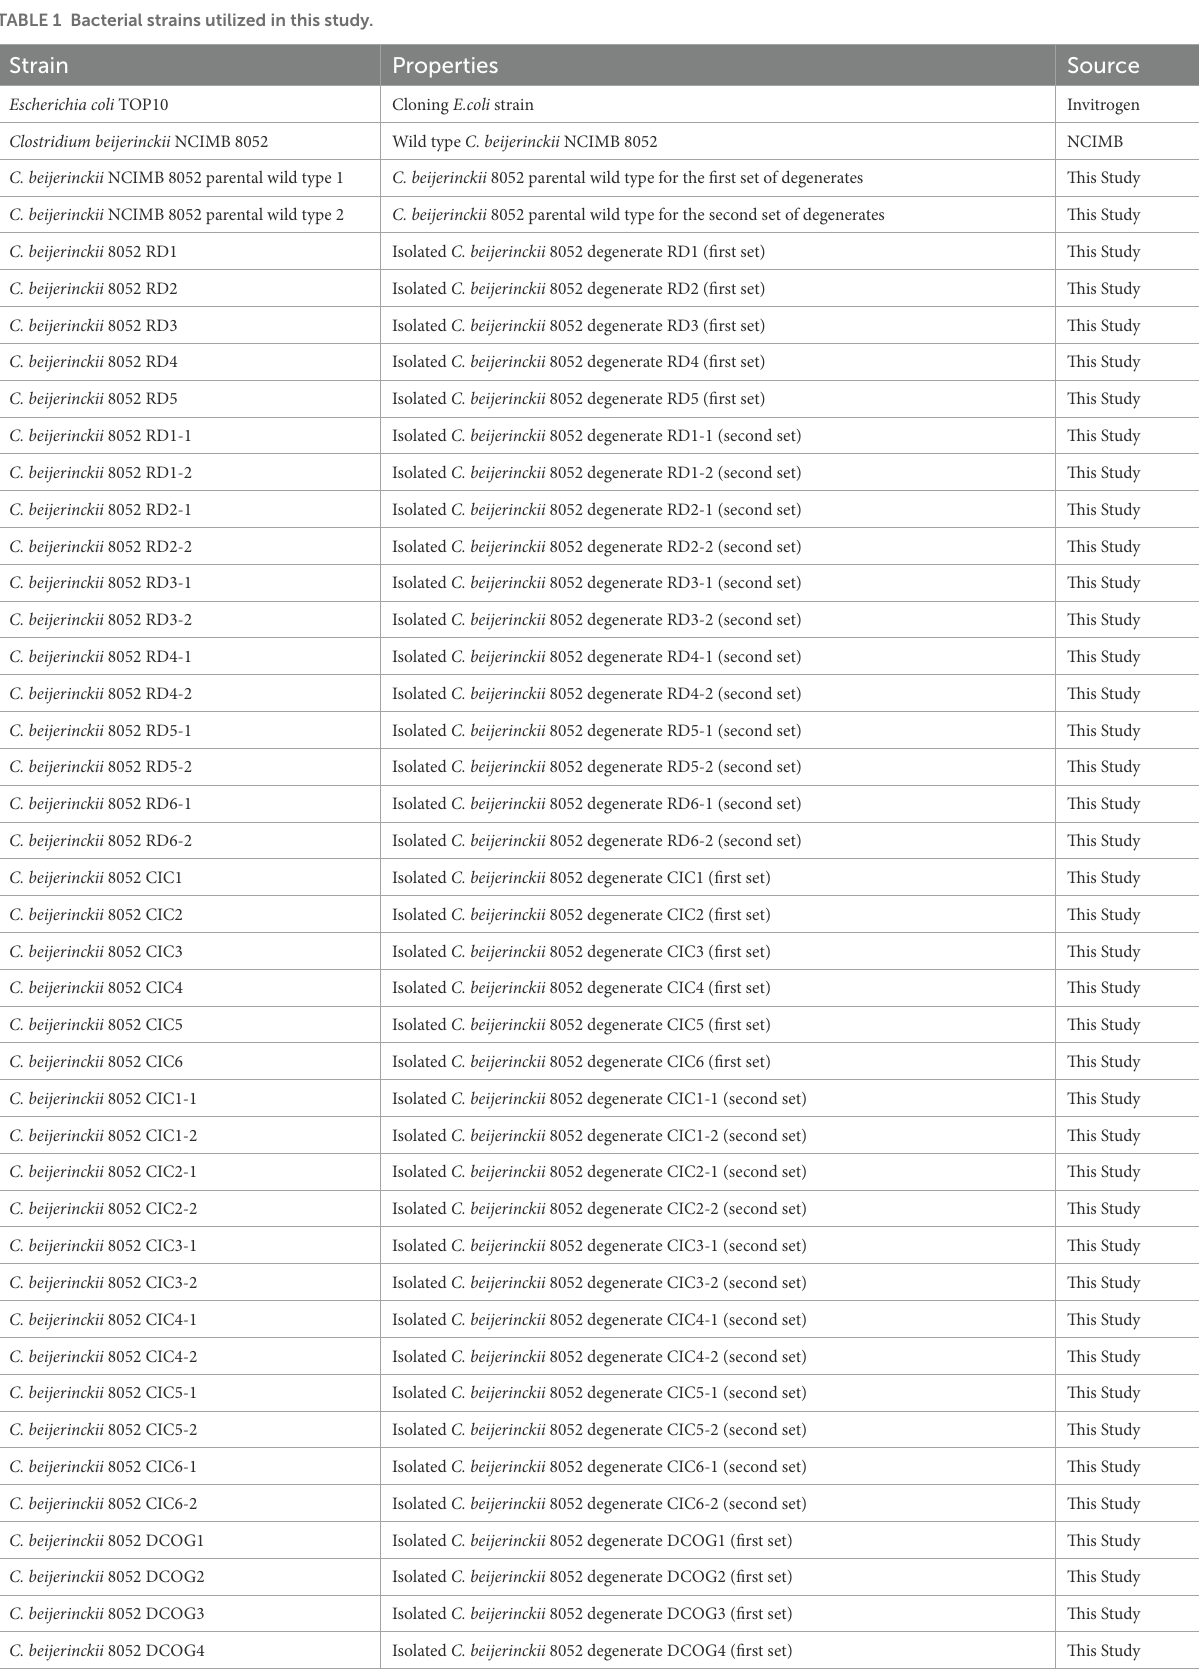
TABLE 1 Bacterial strains utilized in this